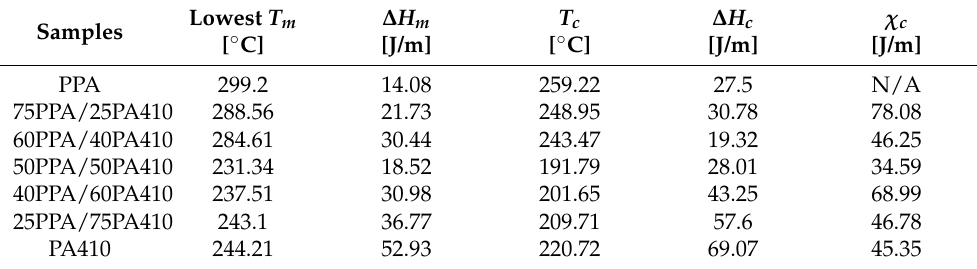
Table 2. Enthalpy of fusion and crystallization, percentage of crystallization of the blends, and apparent miscibility or immiscibility.